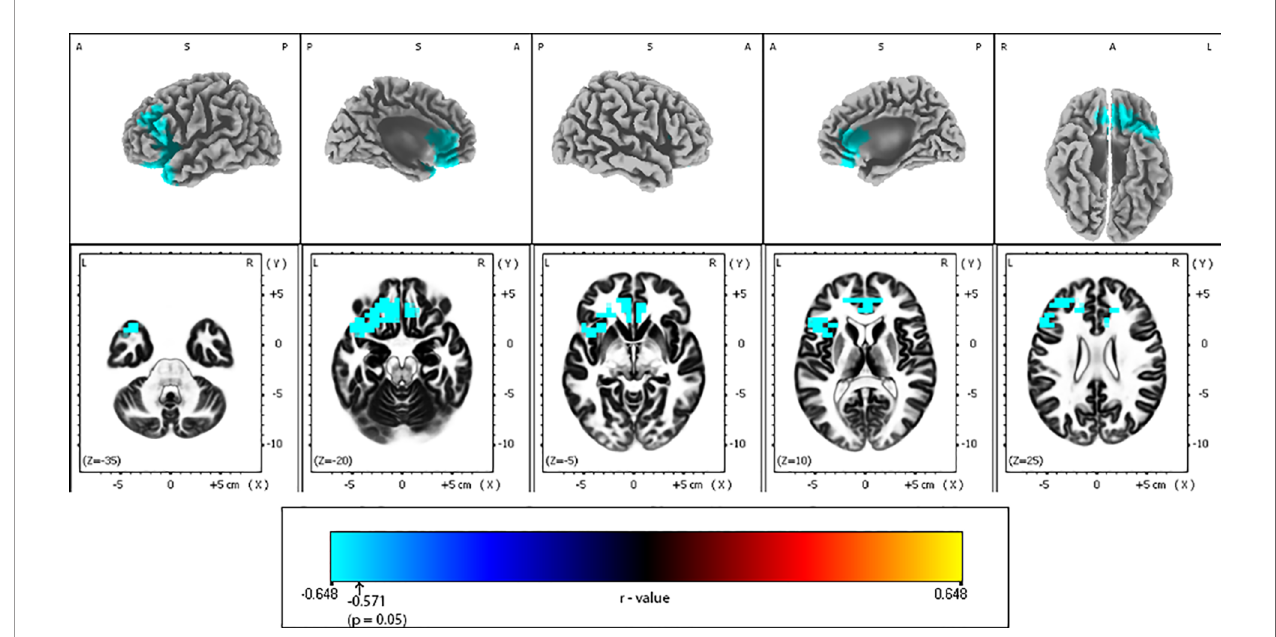
FIGURE 4 | Correlations between Montgomery-Åsberg depression rating scale (MADRS) change and baseline alpha-2 exact low-resolution brain electromagnetic tomography (eLORETA) current density for the whole sample group (N = 25). Surface-rendered (upper row) and axial sliced (lower row) images depicting statistical nonparametric maps (SnPMs) are based on voxel-by-voxel regression analysis of MADRS score change (week 4 vs. baseline) on the baseline eLORETA current density in the alpha-2 frequency band (10.5 – 12 Hz). The signi fi cant negative effect (blue color; threshold: t = -0.571, p < 0.05) was observed between baseline alpha-2 eLORETA current density and the change of MADRS score may be seen in different brain regions: the less the alpha-2 current density mainly over left frontal and anterior cingulate regions, the better the treatment outcome. Structural anatomy is shown in grayscale (L, left; R, right; A, anterior; P, posterior; S, superior); x, y, z = Talairach coordinates. The threshold value (r = -0.571) for statistical signi fi cance (corresponding to p=0.05) is reported at the color scale on the bottom side of the fi gure.